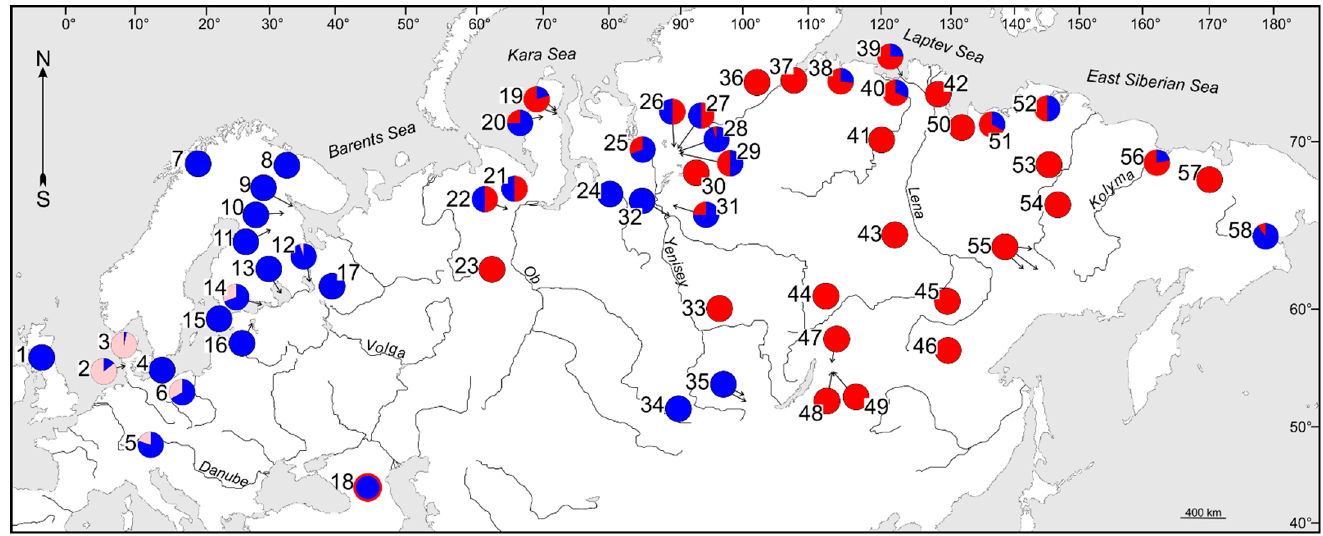
Figure 2. The distribution of phylogenetic mitochondrial lineages of whitefish over water bodies of Arctic Eurasia: red circles–lineage IW, subclade IW2, light pink–lineage IW, subclade IW1, blue–IIW. Location of populations: 1–Loch Lomond; 2–Vidaa River ( C. oxyrhynchus ); 3–waterbodies of Denmark: Nissum and Ringkøbing fjords, Kilen, lakes Tange and Flyder; 4–Achterwasser; 5–Lake Hallstatt and Koppentraun; 6–lakes of Poland: Sremski, Insko, Miedwie, Morzycko, and Marianovo; 7–Havgaj á